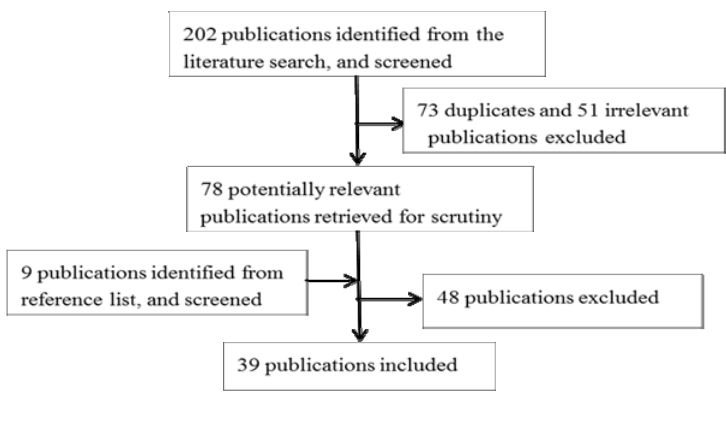
Figure 2. Publication search